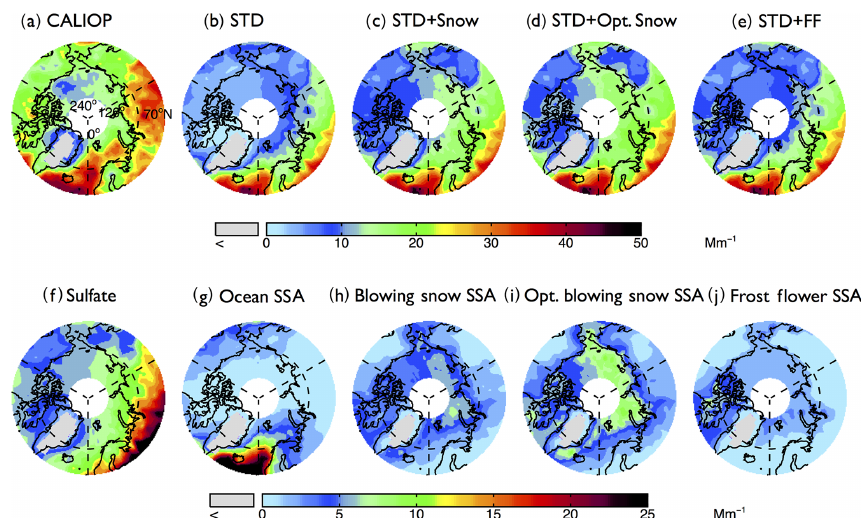
Figure 1. Spatial distribution of mean aerosol extinction coefficients (0–2km) during the 2007–2009 Arctic cold season (November–April), (a) observed by CALIOP and calculated with the GEOS-Chem model in (b) a standard simulation (STD), (c) a simulation including blowing snow SSA emissions (STD + Snow), (d) an optimized blowing snow simulation (STD + Opt. Snow), and (e) a simulation including frost flower SSA emissions (STD + FF). The simulated extinction coefficients are sampled at the time and location of the CALIOP overpasses, and the CALIOP sensitivity threshold is applied. The bottom panels show the extinction coefficients of individual aerosol components in the GEOS-Chem simulations: (f) sulfate aerosol, (g) open ocean SSA, (h) blowing snow SSA, (i) Opt. blowing snow SSA, and (j) frost flower SSA. Note the different color-bar scales for the top and bottom rows.